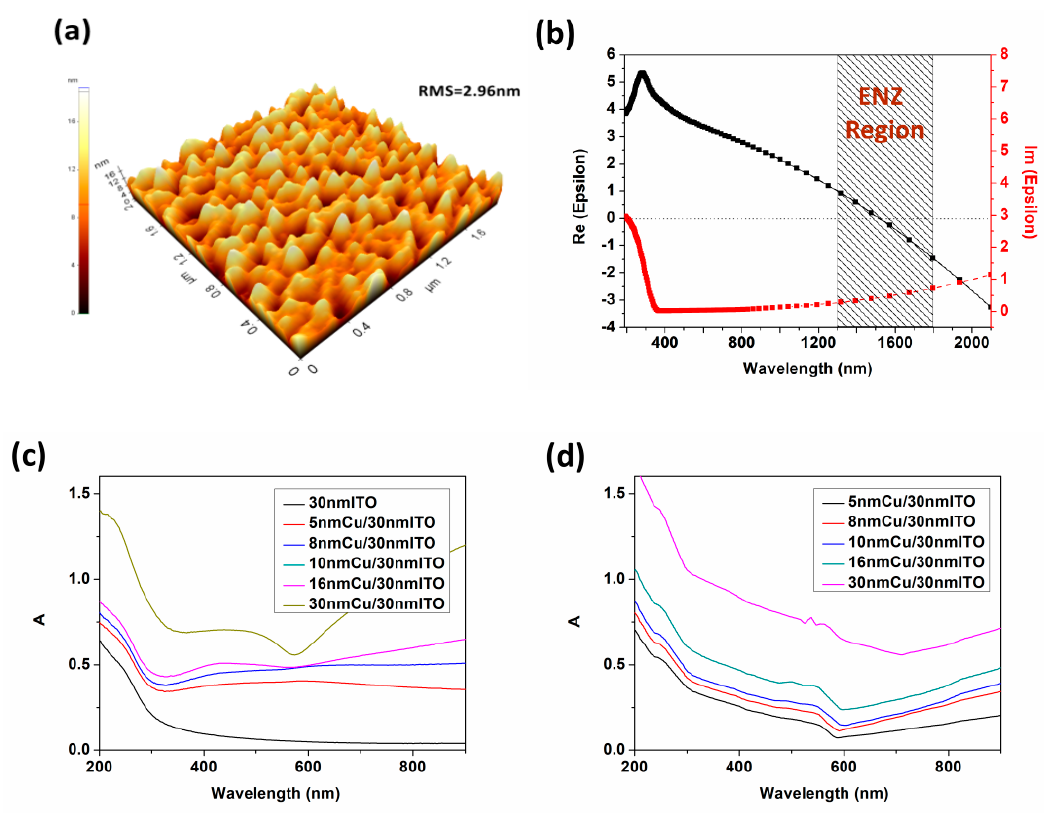
Figure 6. Surface morphology ( a ) and the ENZ region ( b ) of ITO; The absorptions of SiO 2 / Cu / ITO multilayers prepared by experiment ( c ) and calculated by Macleod simulation ( d ).